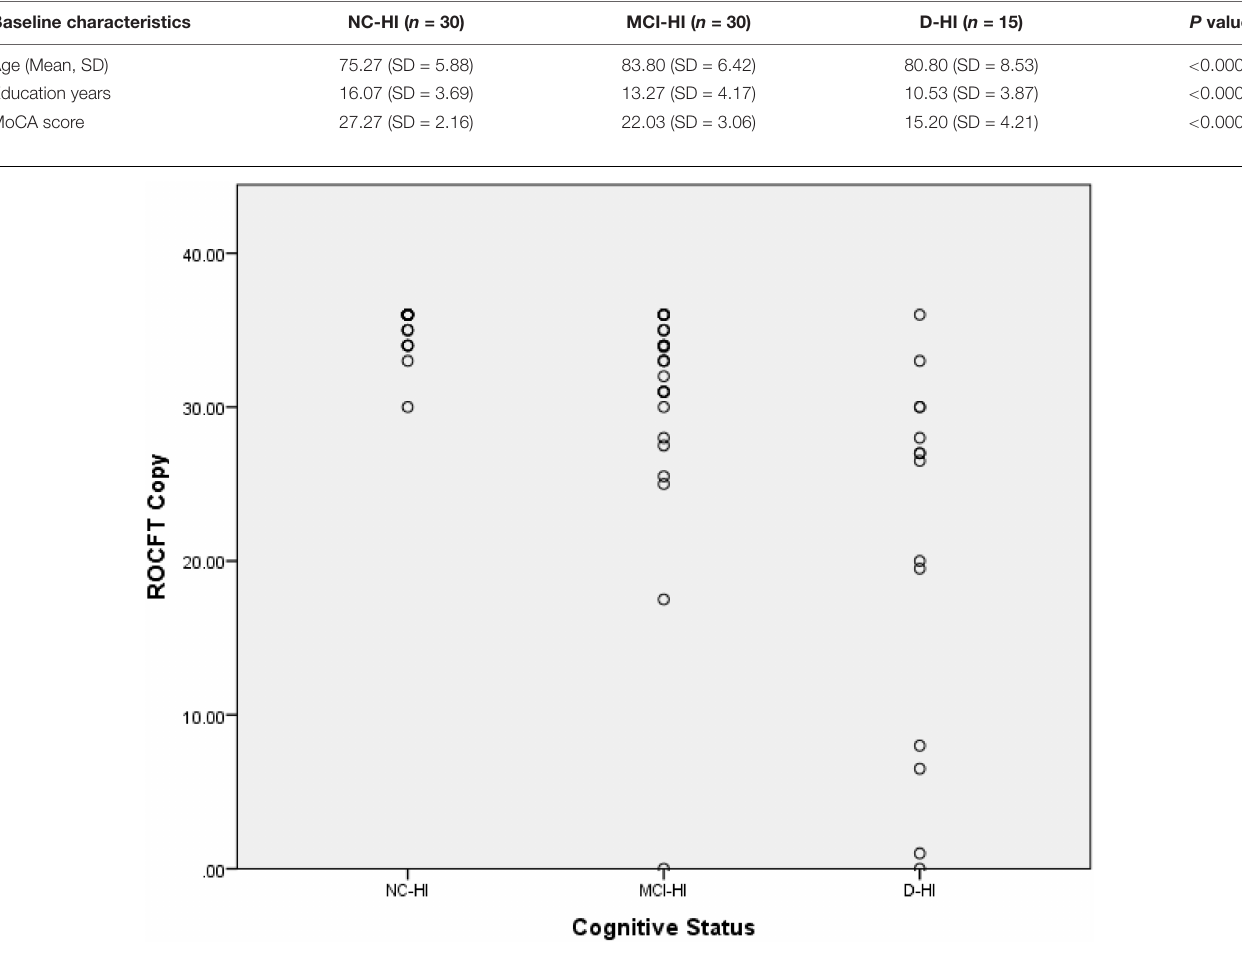
TABLE 1 | Baseline characteristics of the cohorts.